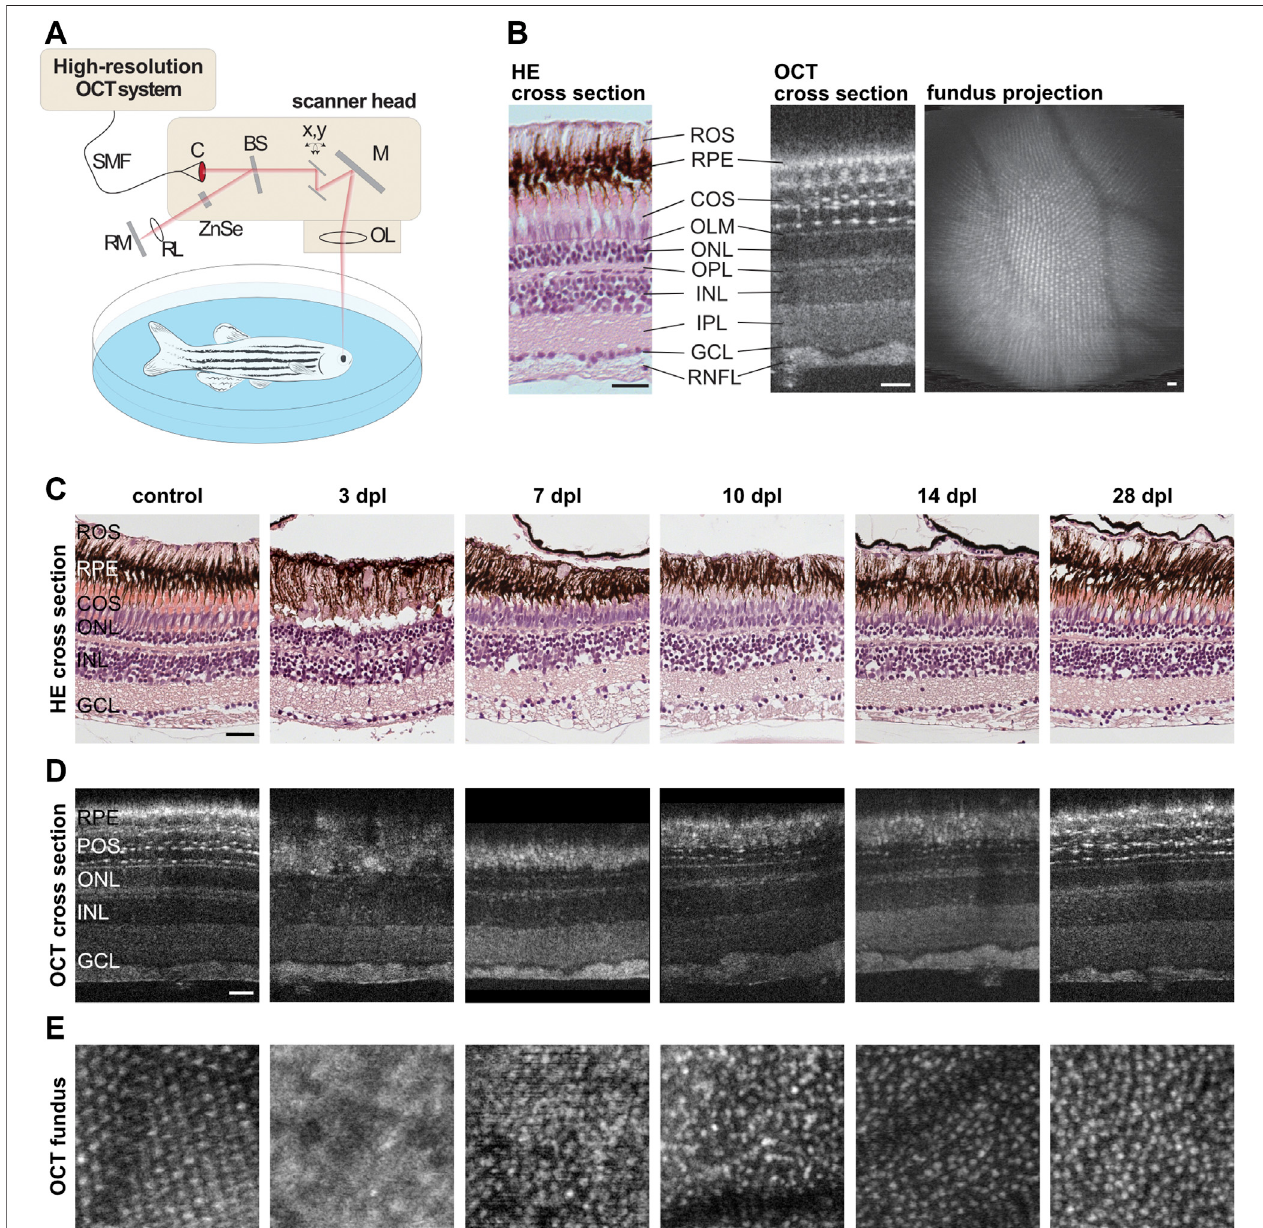
FIGURE 7 | Retinal morphology is restored gradually after light lesion. (A) Scheme of the custom-built high resolution optical coherence tomography (OCT) setup. Laserlightisguidedtothescannerheadviaasingle-mode fi ber(SMF)andtransferredintoafreebeambyacollimator(C).Theincominglightisseparatedintoareference beam and a sample beam by a beamsplitter (BS). The sample light is de fl ected by two galvanometer scanners (x,y) to achieve a 2D scan pattern over the sample, re fl ected byamirror (M)and focused byanadjustablefocuslens(OL)into theeyewhere itisscattered and re fl ected back.Thereferencebeam isguided througha zinc selenide glass (ZnSe) and focused by a lens (RL) before being re fl ected by a mirror (RM). Both beams are superimposed by the beamsplitter, spectrally resolved measured by a linescan sensor. (B) Comparison of a retinal cross section stained with hematoxylin/eosin (HE) and a cross section obtained via OCT imaging revealed a high degree of similarity. With the exception of the rod outer segments (ROS) which can be recognized only in HE stained samples at the top, all subsequent layers includingtheretinalpigmentepithelium(RPE),theconeoutersegments(COS),theouterlimitingmembrane(OLM),theouternuclearlayer(ONL),theouterplexiformlayer (OPL),theinnernuclearlayer(INL),theinnerplexiformlayer(IPL),theganglioncelllayer(GCL)andtheretinalnerve fi berlayer(RNFL)canbeseeninboth,HEandOCT.In addition,smallhyper-re fl ectivestructureswereobservedinthephotoreceptorlayerimagedwithOCTthatmarktheintersectionbetweenconeinnerandoutersegments. Afundusprojectioncalculatedfrom theOCTdatashowedtheconemosaicpattern aswellastheretinalblood vessels inthecentralpart oftheretina. (C) HEstainingsof unlesionedcontrolsamplesaswellasspecimen fi xedat3,7,10,14,and28 dayspostlesion(dpl). (D) OCTcrosssectionsofoneindividual fi shpriortolesionandat3,7, 10,14,and28 dpl.Bothmethodsshowedthelossofphotoreceptorsat3 dpl,theirsubsequentreappearanceat7and10 dplaswellastheirproperdifferentiationat14 and 28 dpl. (E) OCT fundus projections revealed the loss of the cone mosaic at 3 dpl and its subsequent recovery, although the mosaic appeared irregular even at 28 dpl. Scales represent 25 µm.